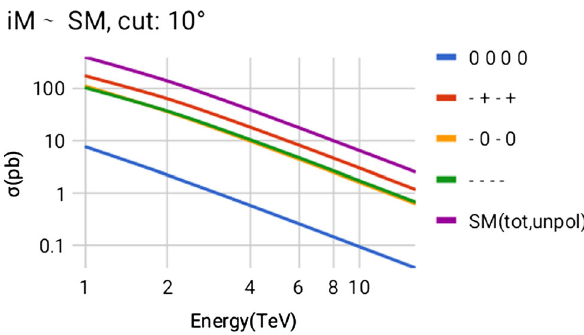
Fig. 5 Contributions of various helicitity configurations (multiplicity taken into account) to the total unpolarized cross section as a function of the center-of-mass collision energy ( E CM ≡ The total unpolarized cross section is shown in